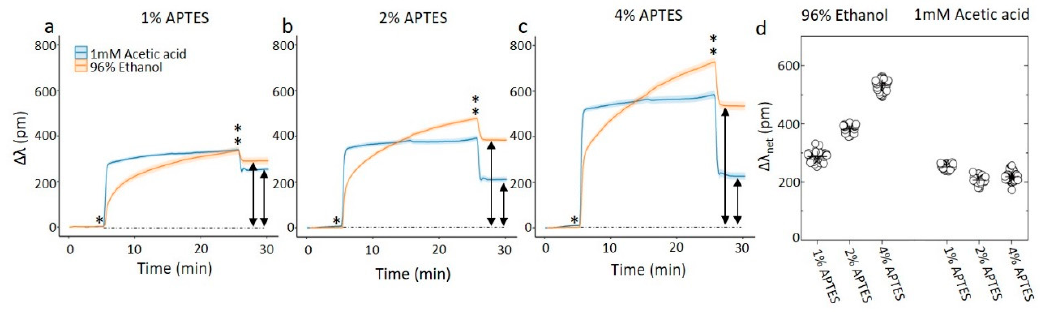
Figure 3. ( a − c ) On-chip monitoring of silanization of a ring resonator chip. The rings are exposed to the solvent for 5 min, before a solution of APTES and the solvent is flowed over the sensor for 20 min. The flow is returned to the solvent for 5 min before ending the experiment. The * denotes the time of APTES introduction to the channel while ** is the time point of return to the solvent without APTES. The graphs each represents the average of at least 47 ring resonators. ( d ) The average net shift, Δλ net (arrows in the figure) of the resonant wavelength as a result of the silanization. The net shift is calculated as the difference between resonating wavelength before and after the silanization step.